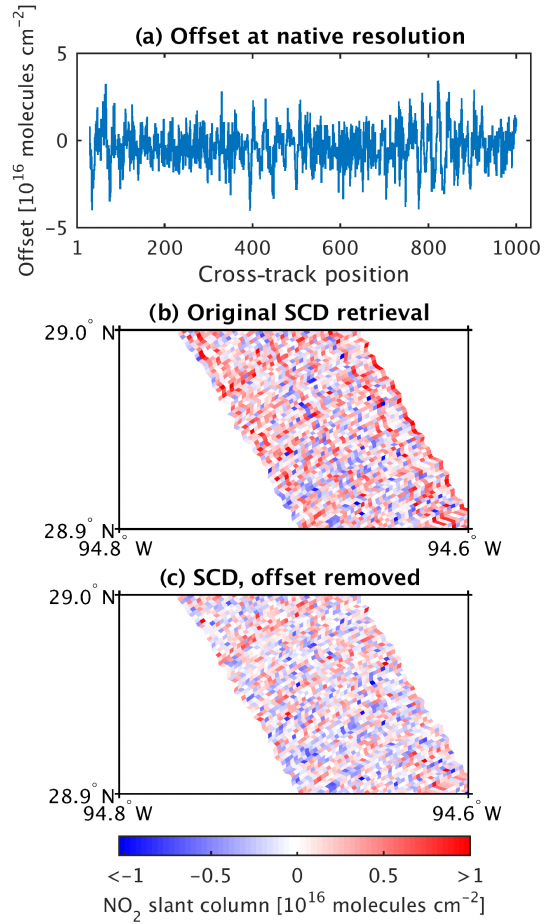
Figure 6. (a) Mean NO 2 slant column density (SCD) as a function of cross-track position for retrievals at native spatial resolution de- rived from 1 million spectra on 13 September 2014 over a relatively clean area in the Gulf of Mexico; (b) original co-added slant column retrieval at 250m × 250m without cross-track striping correction; and (c) co-added slant column density at 250m × 250m corrected for cross-track